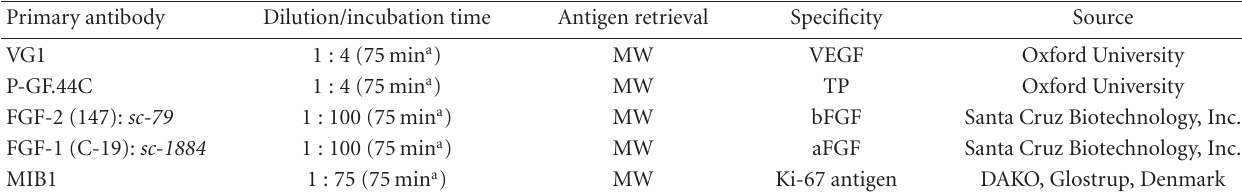
Table 1: Details of the antibodies, dilutions, and antigen retrieval methods used in this study, MW = microwave heating. Primary